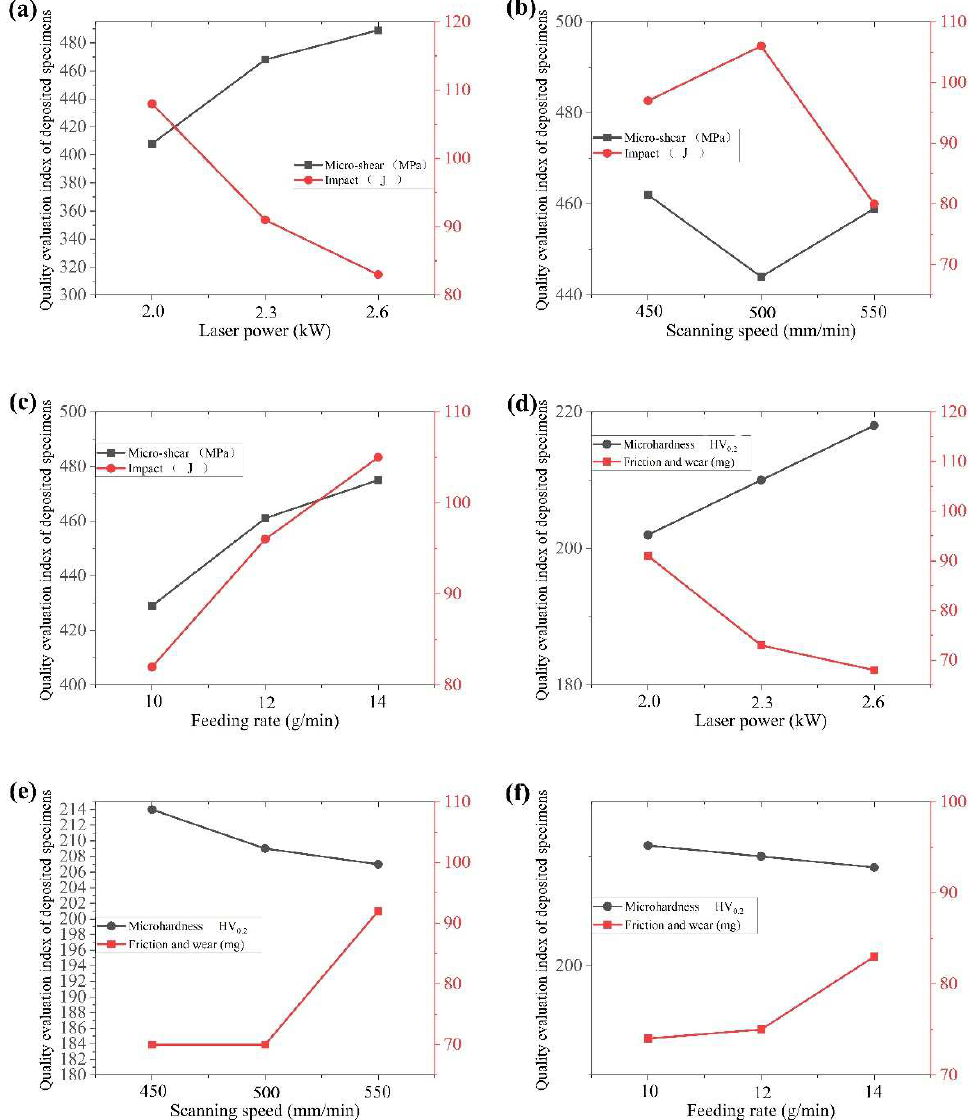
Figure 16. Range analysis: ( a ) variation of micro-shear and impact with laser power; ( b ) variation of micro-shear and impact with scanning speed; ( c ) variation of micro-shear and impact with powder feeding rate; ( d ) variation of microhardness and friction and wear with laser power; ( e ) variation of microhardness and friction and wear with scanning speed; ( f ) variation of microhardness and friction and wear with powder feeding